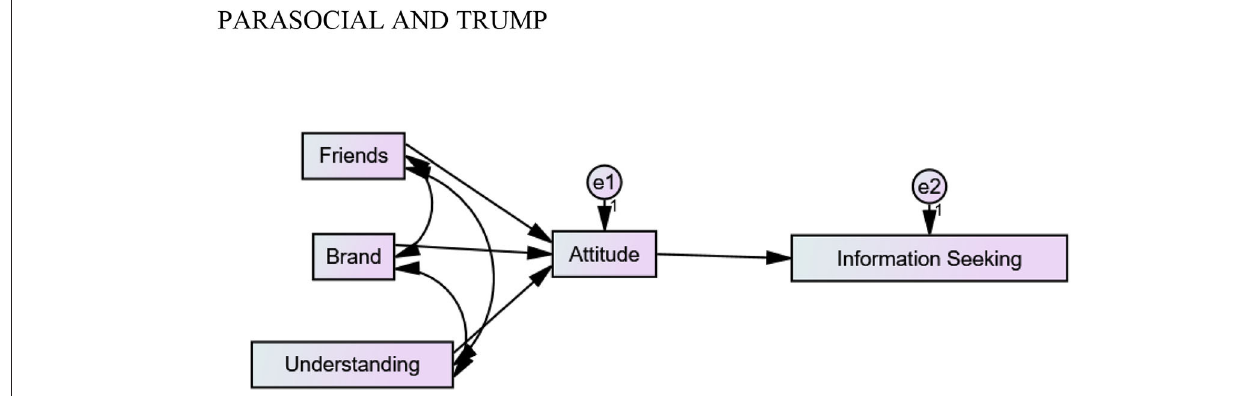
FIGURE 1 | Proposed